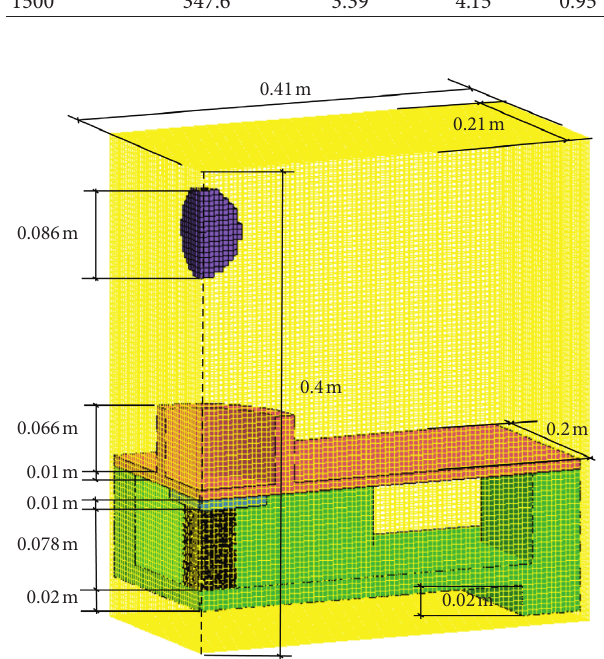
Figure 4: Sandwich plate